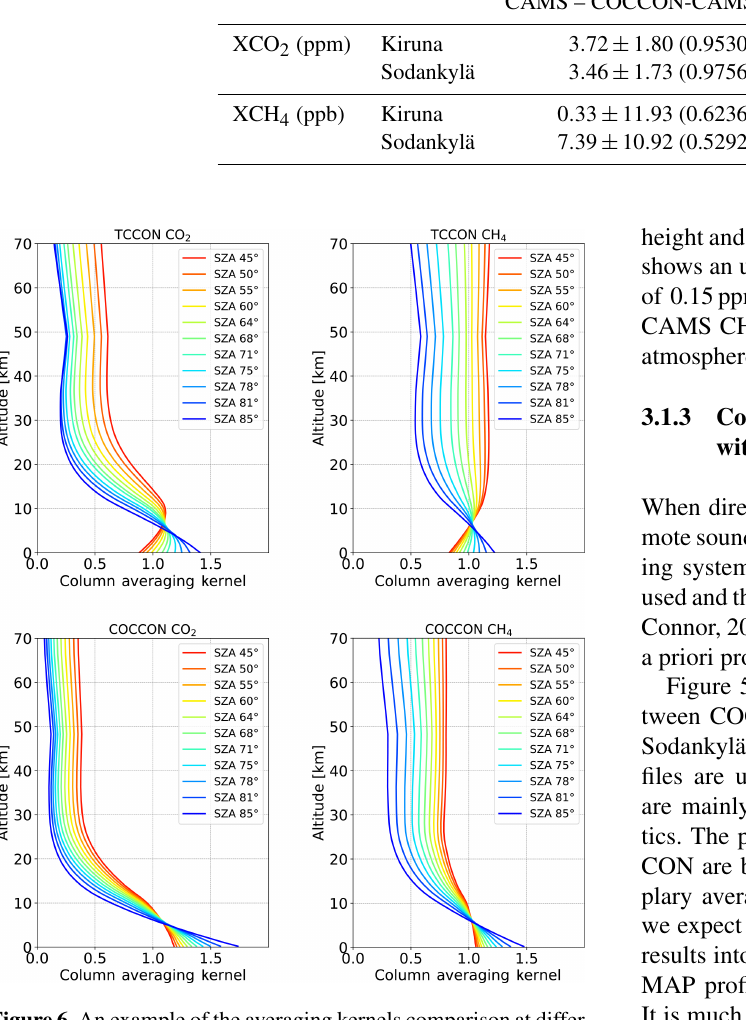
Figure 6. An example of the averaging kernels comparison at differ- ent SZAs for the TCCON and COCCON instruments performed on 8 June 2017. The COCCON instrument is generally less sensitive to changes in